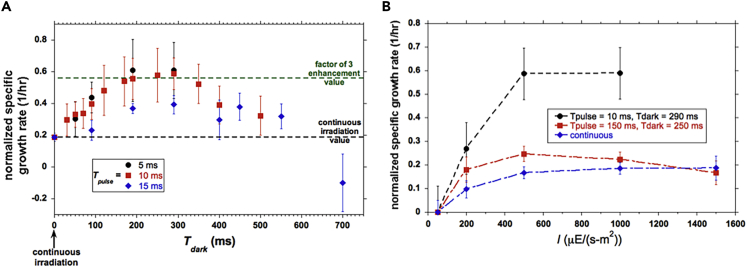
Measured Normalized Specific Growth RateAs a function of: (A) Tdark for pulsed light with I = 1,000 μE/(m2-s) at Tpulse = 5, 10, and 15 ms and (B) I for both continuous irradiation and pulsed light. Vertical bars indicate ±1 standard deviation about the average. Each data point comes from 20 replications for experiments with continuous light and 8 replications for experiments with pulsed light.